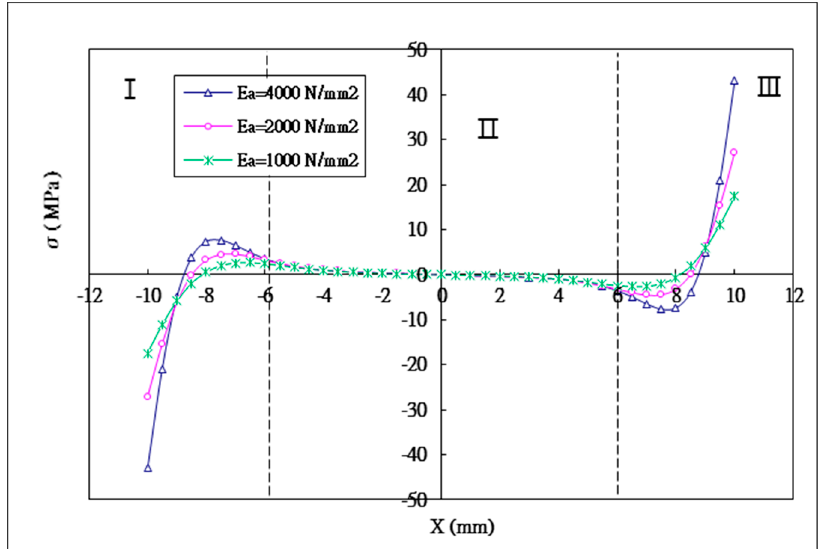
Figure 10. Peel stress distribution in the adhesive with three different Young’s moduli of the adhesive.